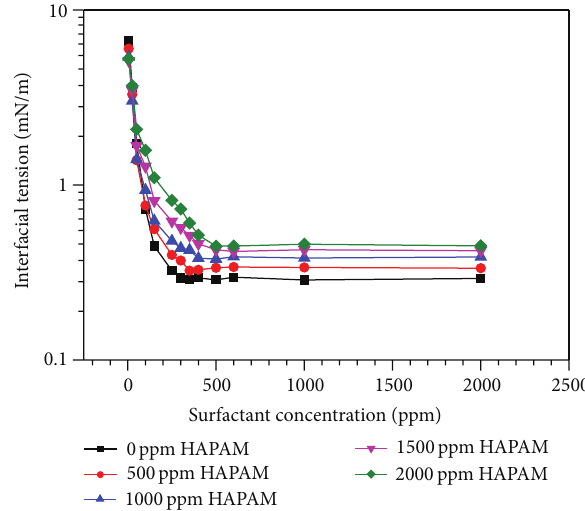
Figure 4: Effect of HAPAM concentrations on interfacial tensions of BS-12.